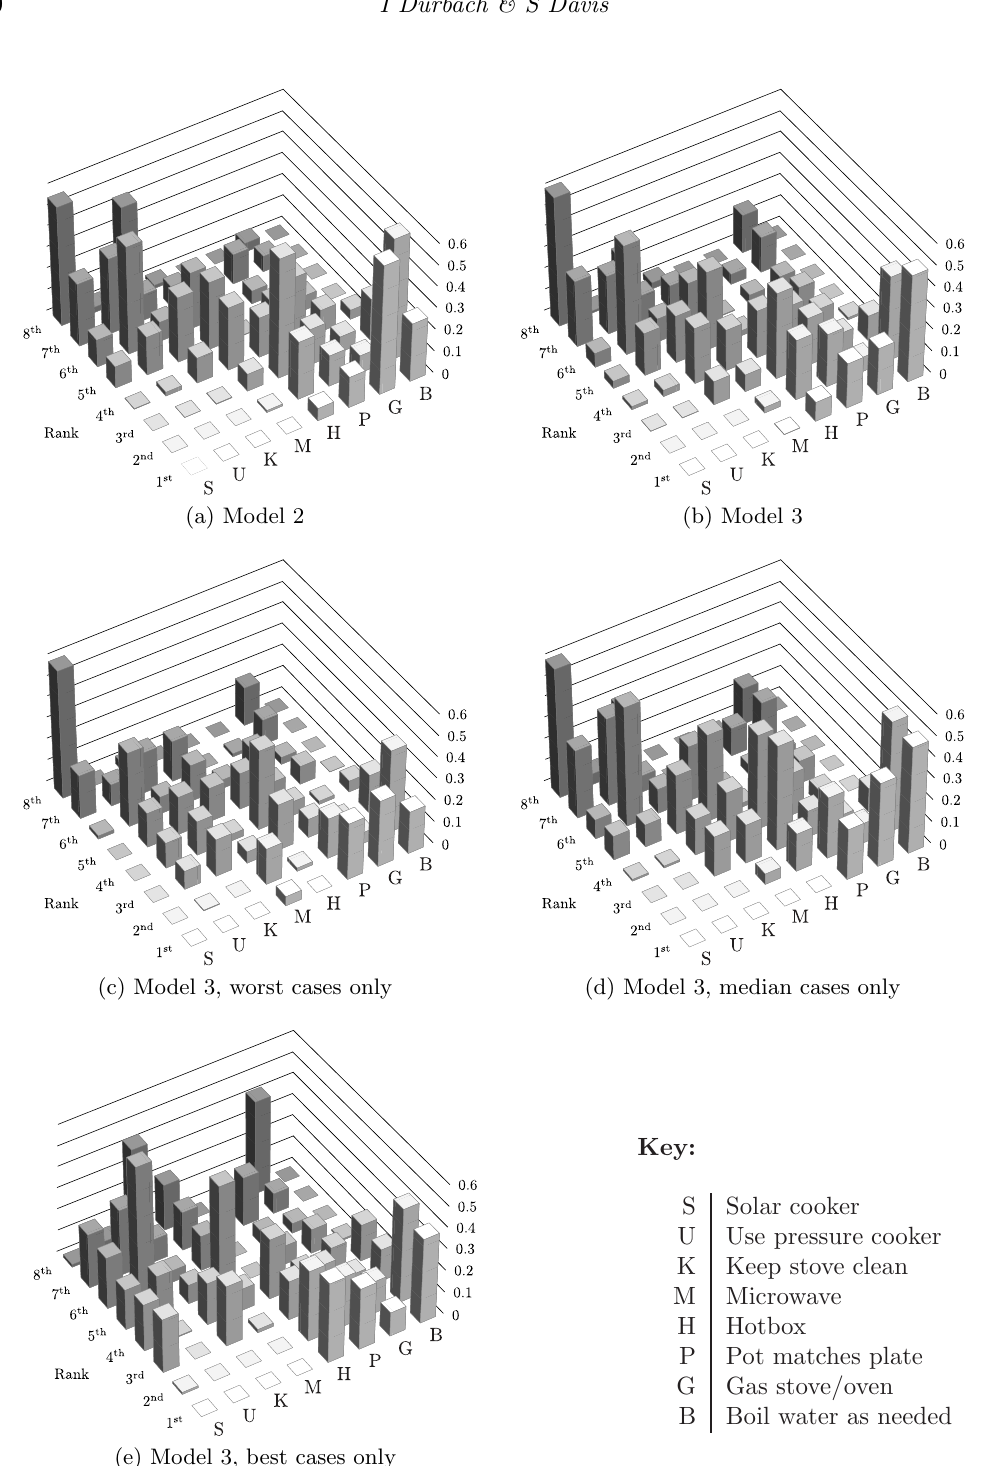
Figure 3: Acceptability indices for electricity savings options obtained with an adapted SMAA- O